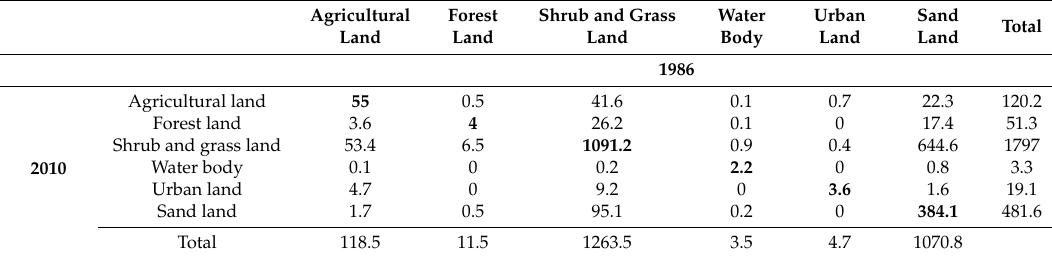
Table 7 lists the mean annual hydrological components simulated by the SWAT model under different climate variability scenarios. The hydrological components include surface flow, lateral flow, baseflow, and evapotranspiration. All simulated hydrological components under S1 decreased as compared with S0. From the perspective of quantity, the largest decrement occurs in